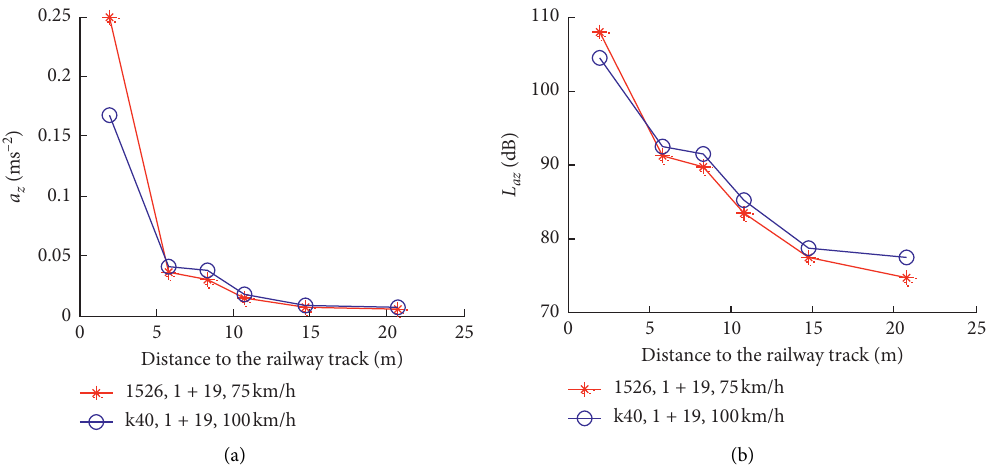
Figure 8: Attenuation mechanism of the vibration response at driving speeds during the frozen period: (a) vibration acceleration; (b) vibration